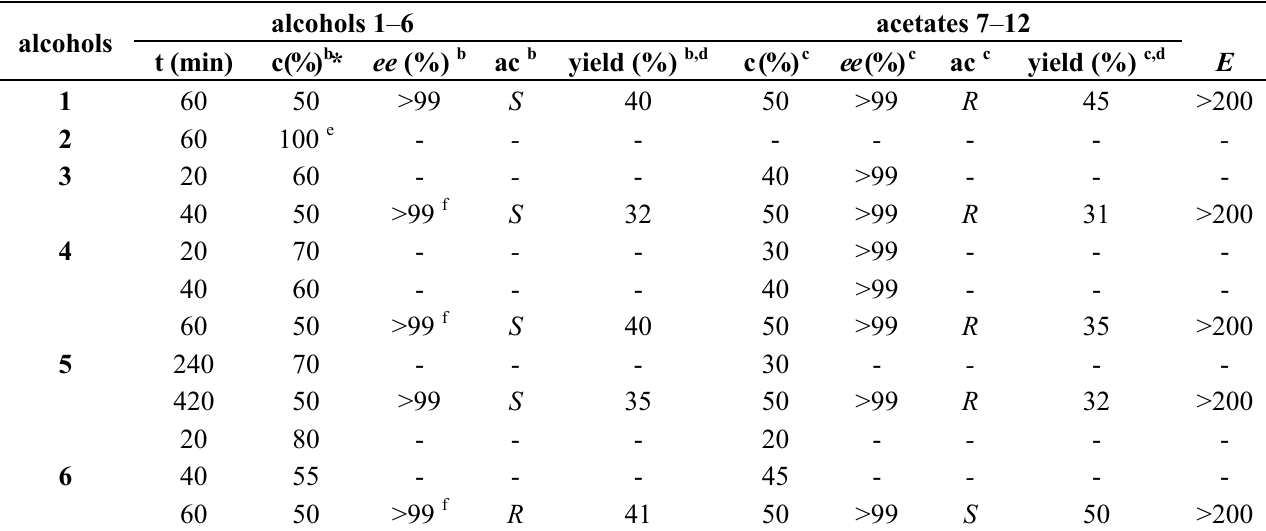
Table 1. Enzymatic transesterification of (±)-secondary alcohols 1 – 6 by lipase B from Candida antarctica a